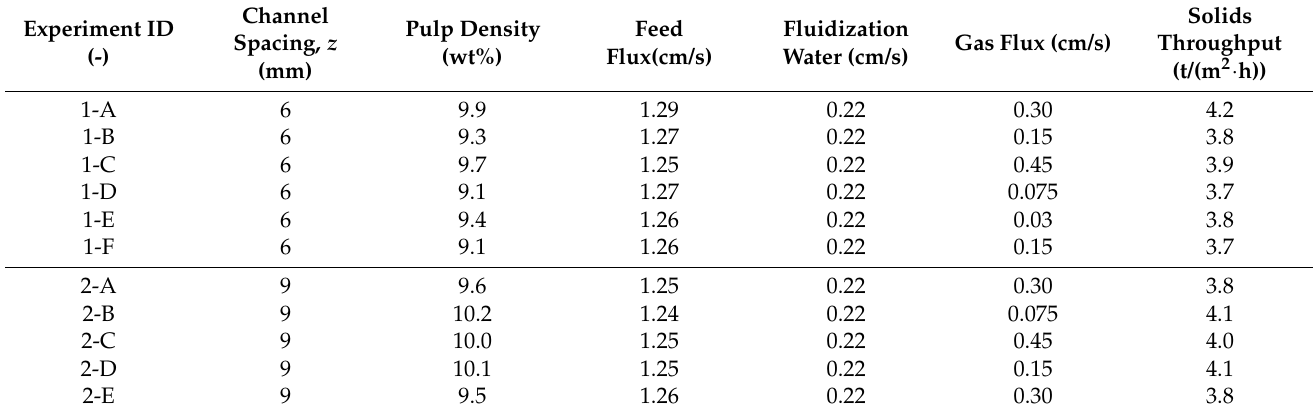
Table 1. Parameters for each experiment.